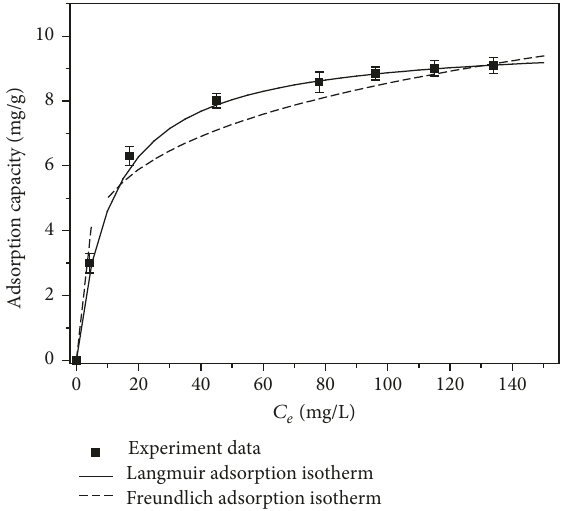
Figure 10: Thermodynamic models for fitting Sb(III) adsorption using Fe 3 O 4 /GO.